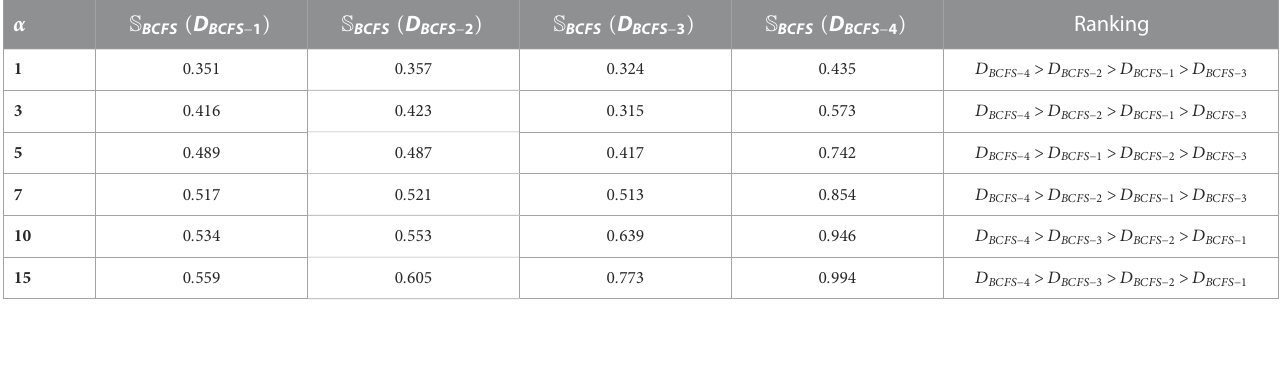
TABLE 8 Score values and ranking order for various values of α using the BCFPDWA